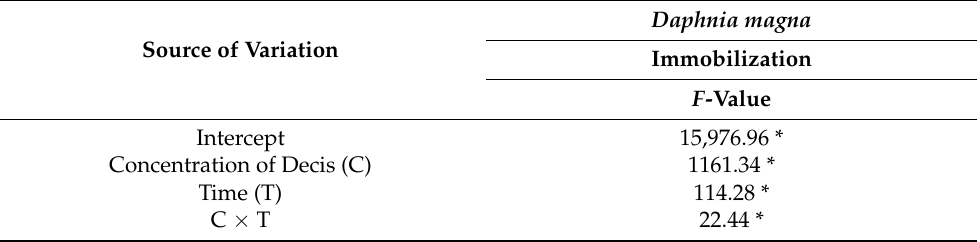
Table 1. Analysis of variance (ANOVA) for immobilization of Daphnia magna exposed to Decis ® 2.5 EC.